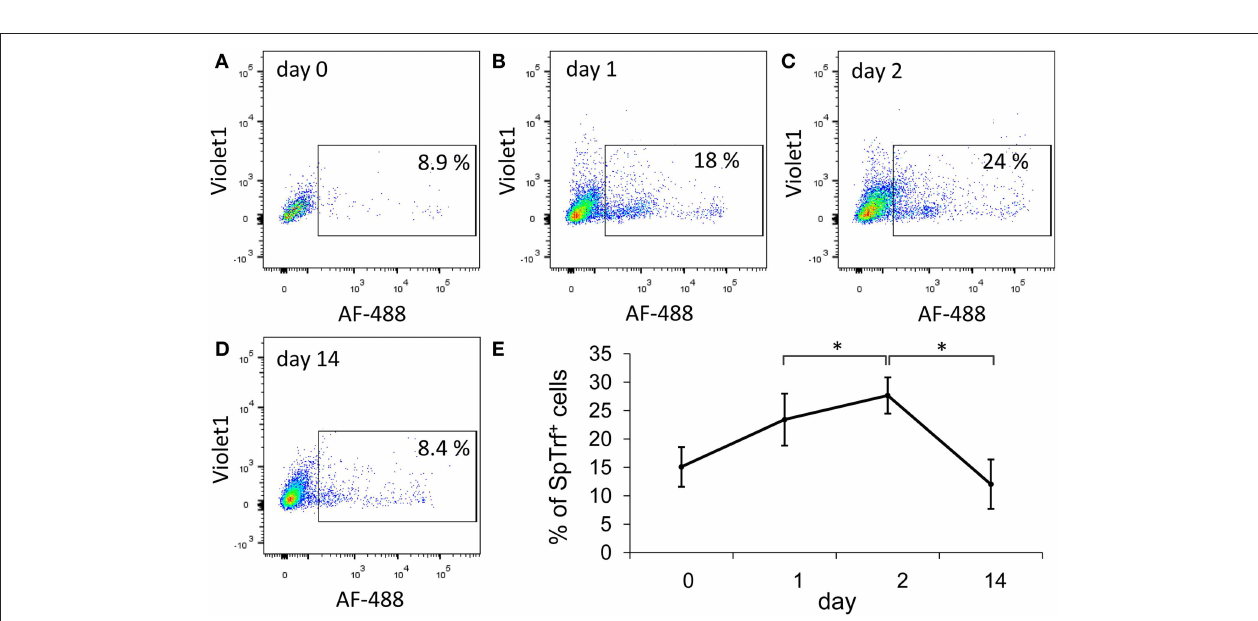
FIGURE 2 | The percentages of SpTrf + small phagocytes in the coelomic fluid increase in response to Vibrio challenge. Three adult sea urchins were injected with heat-killed Vibrio diazotrophicus . Coelomic fluid (CF) was collected prior to injection (day 0) and after injection on days 1, 2, and 14. (A–D) Cells were incubated with a mix of three anti-SpTrf (formerly anti-Sp185/333) primary antibodies followed by incubation with a secondary antibody labeled with Alexa Fluor 488 (AF-488) to identified SpTrf + cells. Nuclear staining with propidium iodine was used to exclude dead cells. Results for sea urchin 1 are shown. Percentages of live SpTrf + coelomocytes from animal 1 at all time points are shown within the rectangular gate. SpTrf + coelomocytes increase to the highest recorded level on day 2 post challenge and return to the basal level by day 14. (E) The mean of the percentages of SpTrf + coelomocytes for the three individual animals at different time points are shown. Differences in the percentages of SpTrf + cells over time for the individual animals were significant by Anova two factor analysis ( p < 0.05). Additionally, the day 2 time point was analyzed compared to days 1 and 14 time points using Anova single factor (*indicates p < 0.05). Vertical bars indicate standard